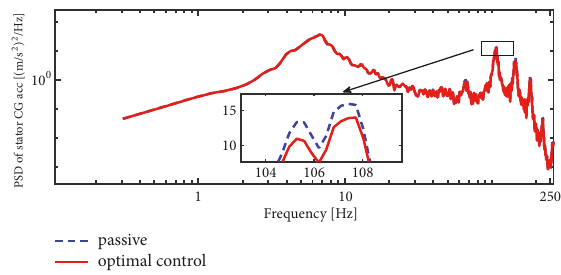
Figure 13: Frequency response of stator acceleration.